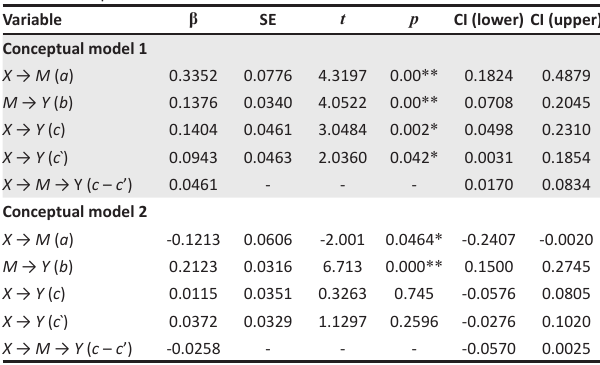
TABLE 2: Simple mediation model results.